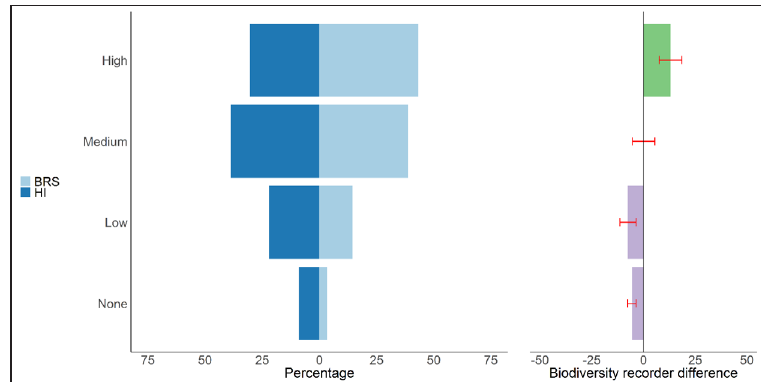
Figure 5: International Physical Activity Questionnaire (IPAQ) score distribution of biodiversity recorders compared with that of older adult population in Ireland using Healthy Ireland Survey (HI). Note that 95% confidence intervals are based on difference in proportions tests. Table 4: Health and well-being characteristics of biodiver- sity recorders compared with those of older adult popu- lation in Ireland using The Irish Longitudinal Study on Ageing